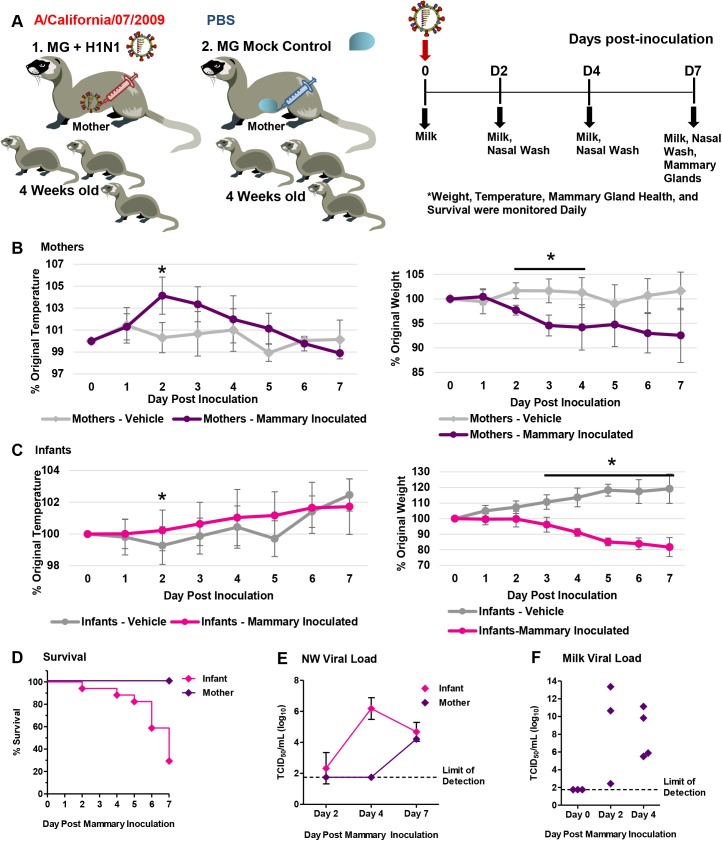
Influenza virus inoculation into active mammary glands of nursing-mother ferrets leads to respiratory infection, severe disease and mortality in infants.A schematic depicting the mammary gland inoculation design is shown (A). Temperature (left panel) and weights (right panel) of lactating mother ferrets following 2009 H1N1 (pink lines) or PBS (light grey lines) mammary inoculation (B). Temperature (left panel) and weights (right panel) of infants feeding from lactating mothers with 2009 H1N1 (pink lines) or PBS (light grey lines) inoculated mammary glands (C). Survival of mother and infant ferrets following mammary 2009 H1N1 virus inoculation (D). Live viral load determined from nasal wash in both infant and mothers (E), and live virus shedding from expressed milk (F) following mammary gland 2009 H1N1 inoculation. * Indicates a p-value less than 0.05 determined by ANOVA. Error bars indicate +/- SD. Results are the mean of or represent three independent mammary gland inoculation experiments (3 mammary inoculated mothers, 18 infants) and mock mammary inoculation controls (3 mammary mock inoculated mothers, 21 infants).